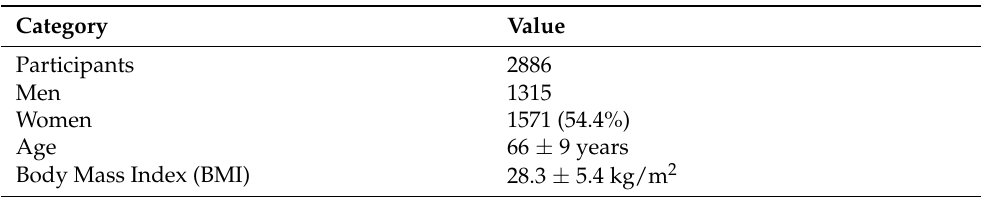
Table 1. Summary statistics of surveyed participants. Participants are from the Framingham Offspring Cohort Exam